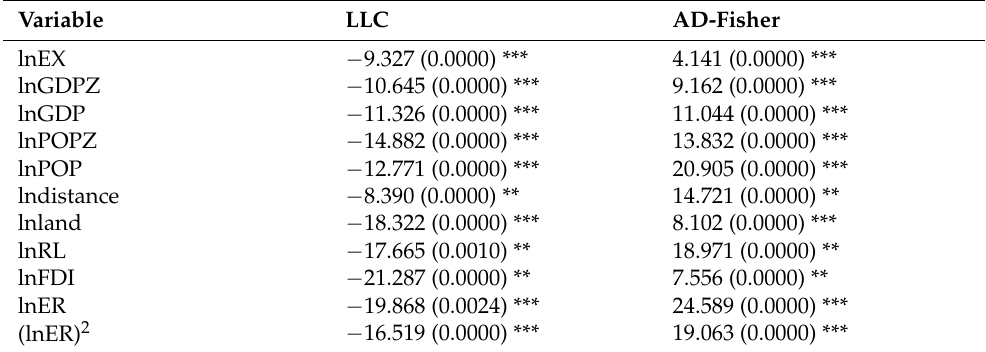
Table 1. Stationarity test result.